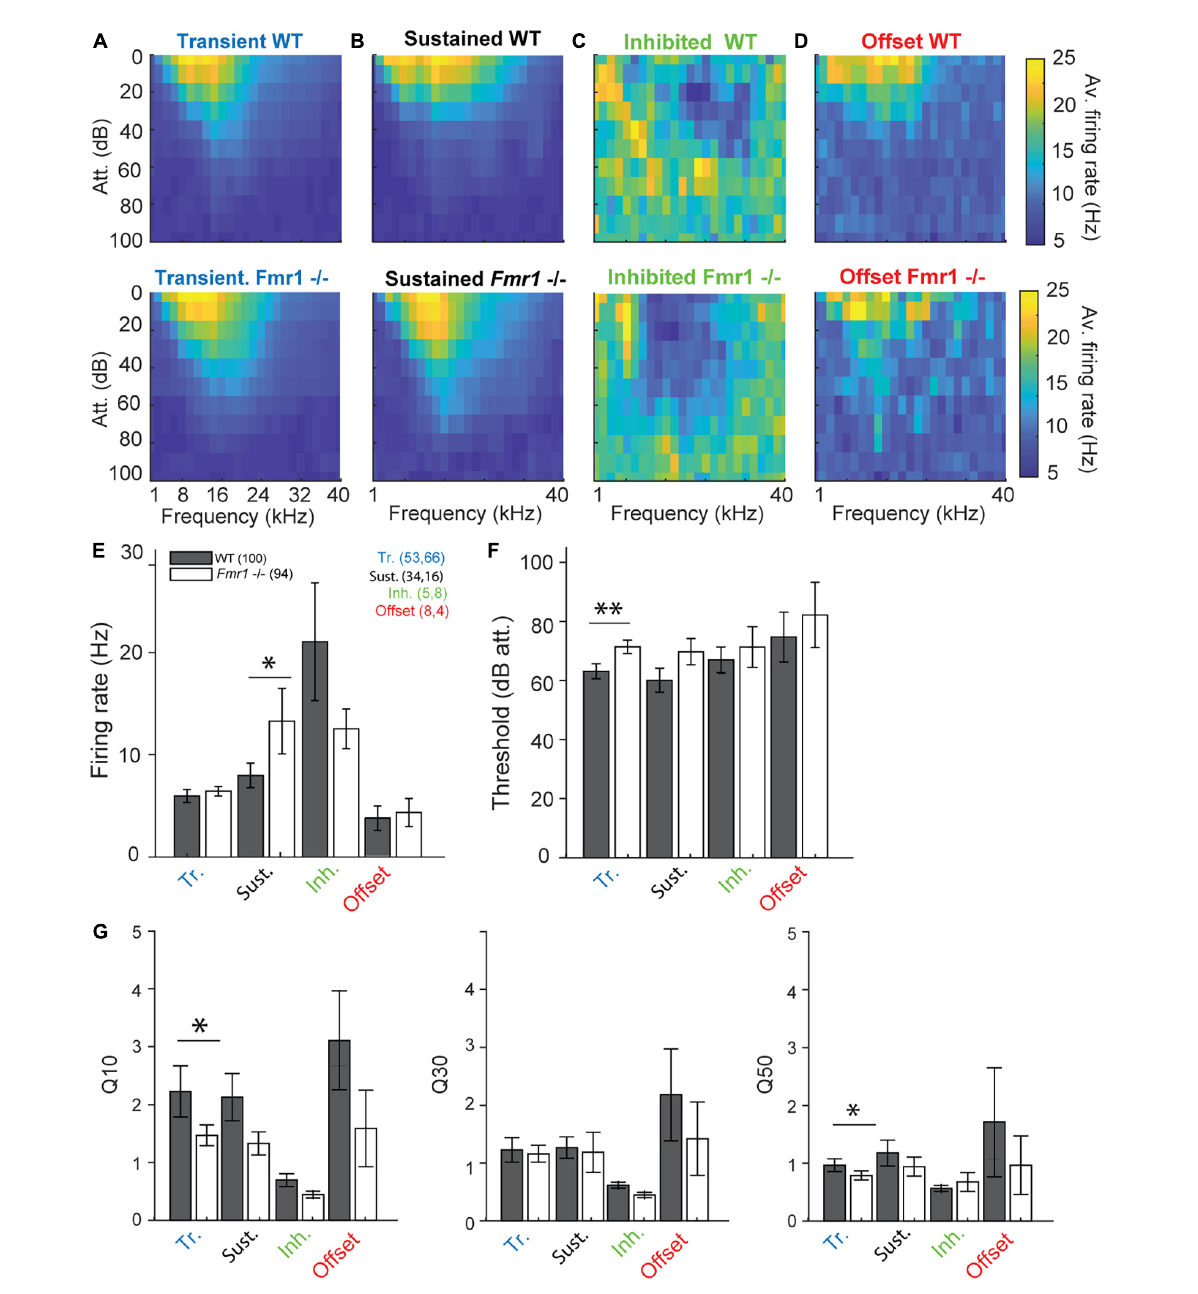
FIGURE3 Fmr1 -/- neurons are over-activated and oversensitive. (A) (above) Averaged of all WT transient neurons FRA, and (below) all their Fmr1 -/- counterparts. (B) (above) Averaged of all WT sustained neurons FRA, and (below) their Fmr1 -/- counterparts. (C) (above) Averaged of all WT inhibited neurons FRA, and (below) their Fmr1 -/- counterparts. (D) (above) Averaged of all WT offset neurons FRA, and (below) their Fmr1 -/- counterparts. (E) Averaged firing rate of each of the 4 classes. (F) Average threshold of the 4 classes together. (G) Averaged Q -values measured in each neuron, resp. (Left) Q10, (middle) Q30, (right) Q50.